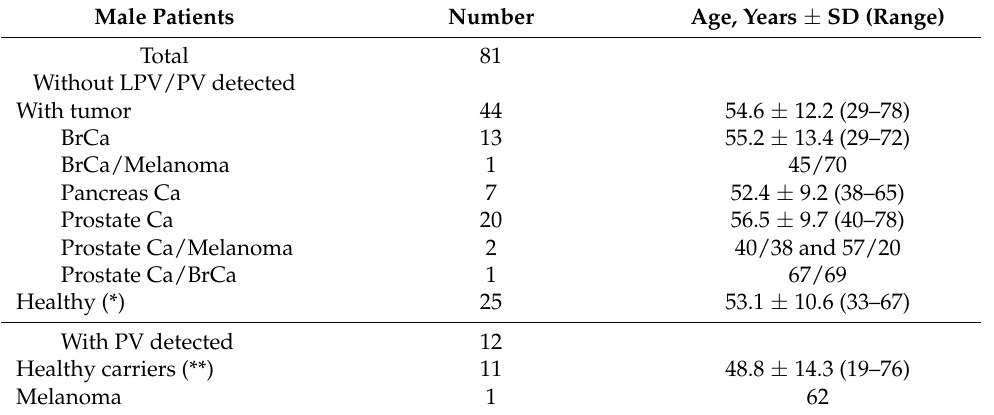
Table 6. Summary of the results in male patients. Male